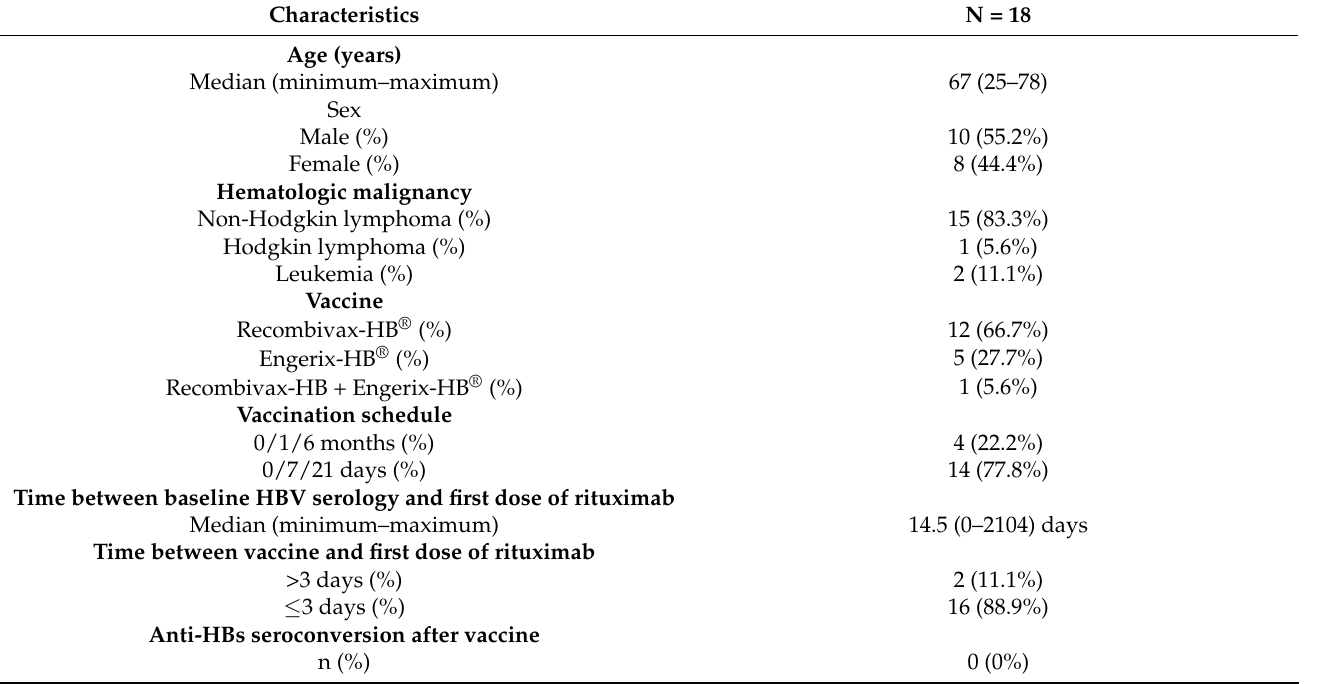
Table 5. Baseline characteristics of the patients in the vaccine